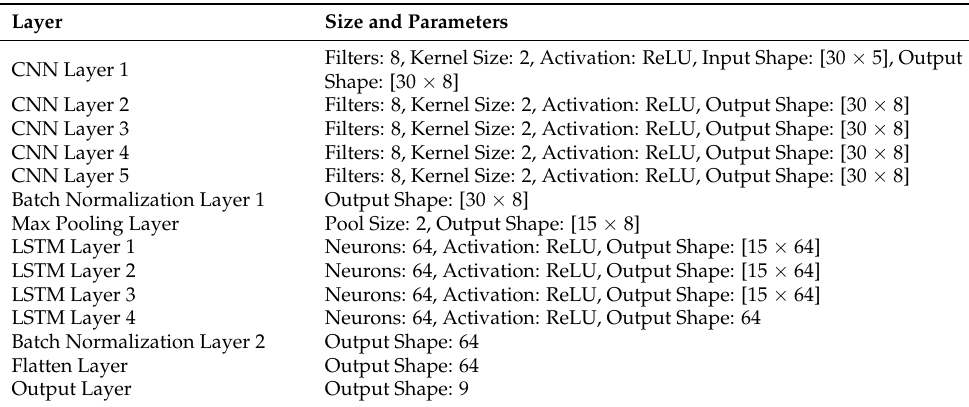
Table 3. The architecture parameters of the proposed